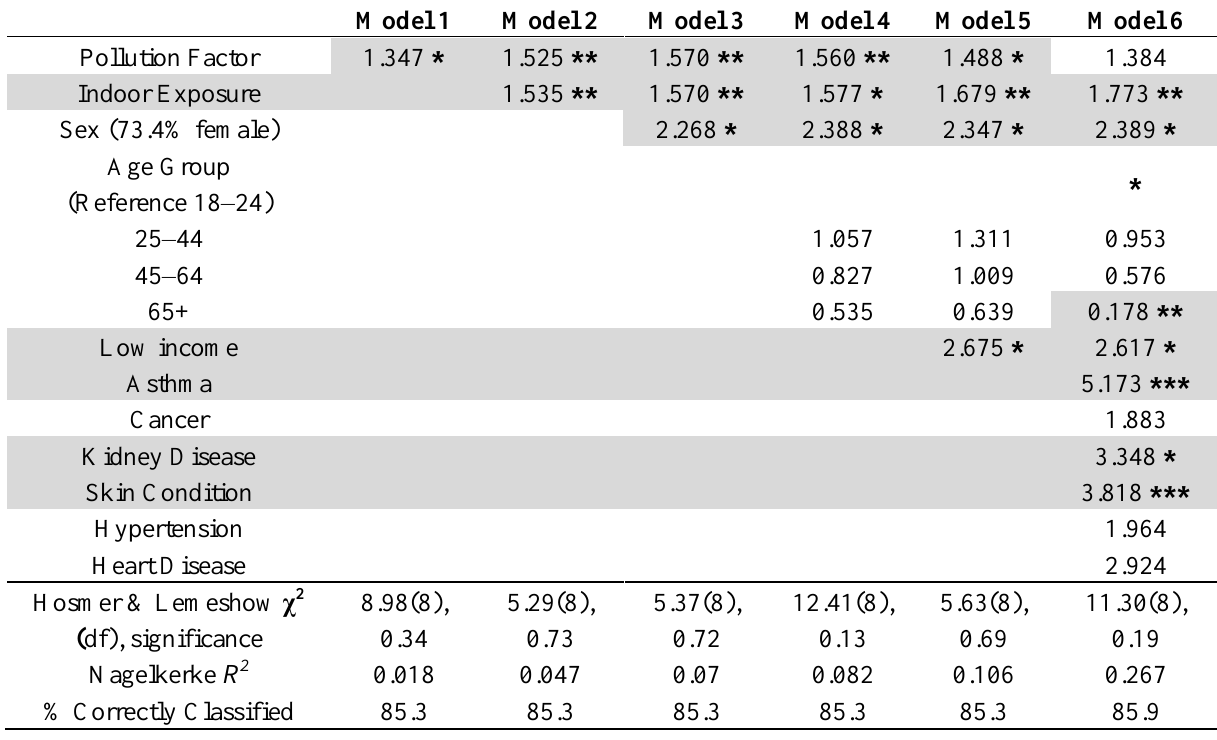
Table 3. Odds ratios for 5+ cardinal symptoms—no occupational exposure (n = 432).